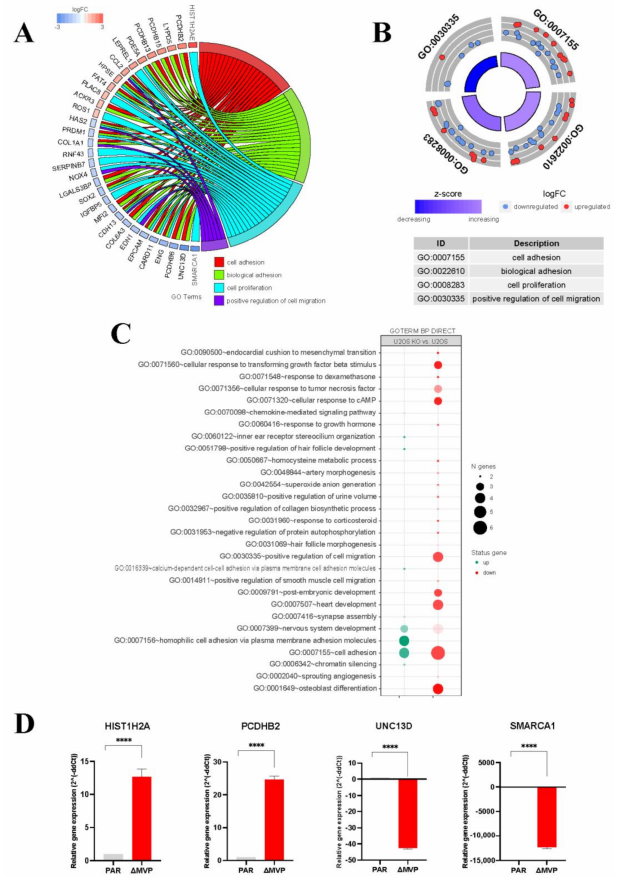
Figure 4. Comparative transcriptomic analysis of parental U2OS cells and MVP-negative U2OS cells ( ∆ MVP, clone c5). ( A ) Representation of relatively highest and lowest expressed genes in MVP- negative U2OS cells compared to U2OS parental cells. The fluctuations in biological processes in U2OS- ∆ MVP cells are marked with colors. ( B ) Bioinformatical analysis of gene ontology (GO) related to biological processes in parental and MVP-negative cells (clone c5). The processes disturbed in MVP-negative U2OS were selected and presented in the table below the pie chart. ( C ) Extended GO analysis shows the contribution of individual processes in parental U2OS cells and MVP-negative U2OS cells. ( D ) RT-qPCR analysis of selected high and low expressing genes in MVP-negative U2OS cells compared to the parental U2OS cells (**** p <